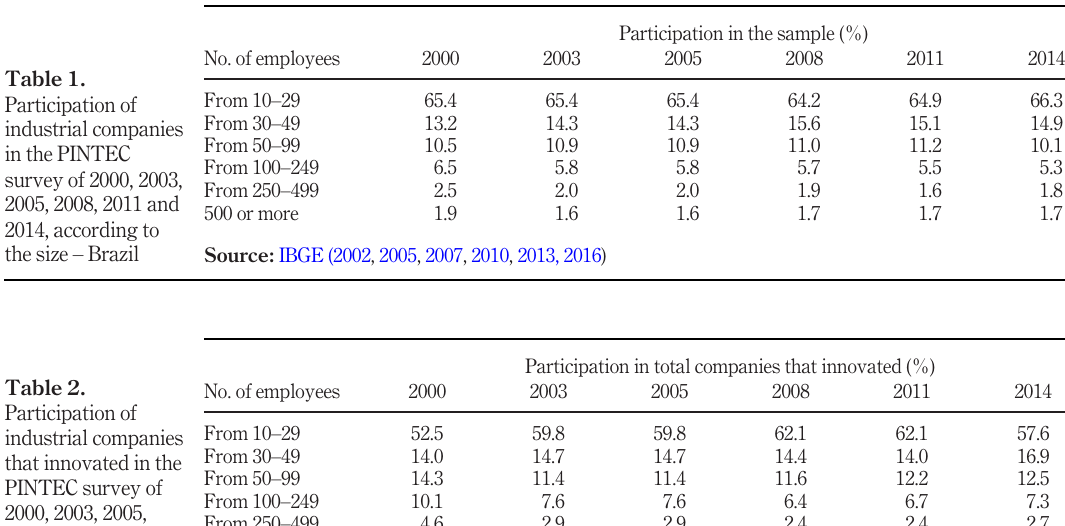
industrial companies that innovated in the PINTEC survey